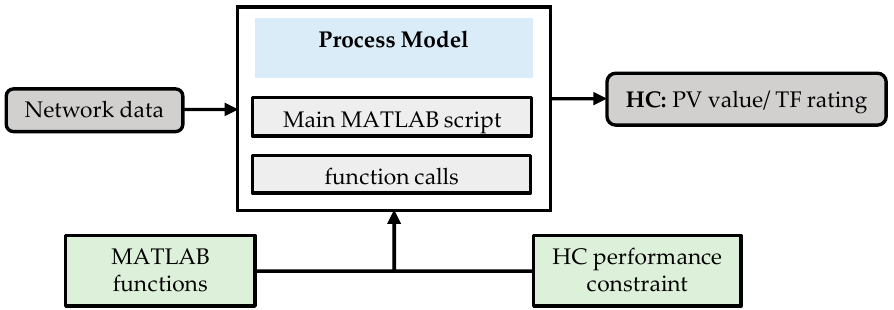
Figure 1. The process model for economical hosting capacity assessment.